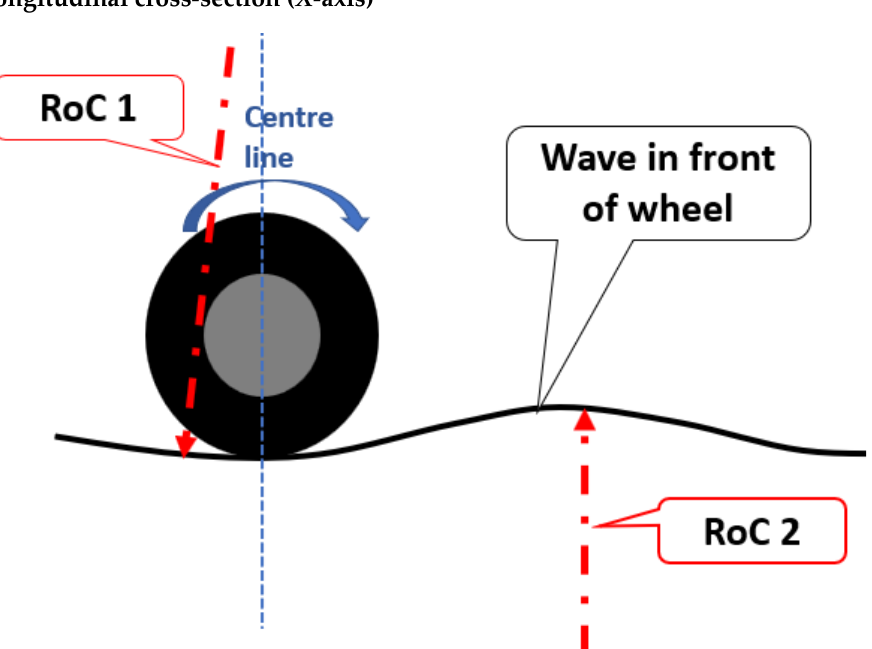
Figure 7. Bow waves alongside and in front of boat and standing wave behind fast-moving boat on the right. Longitudinal cross-section ( X -axis)